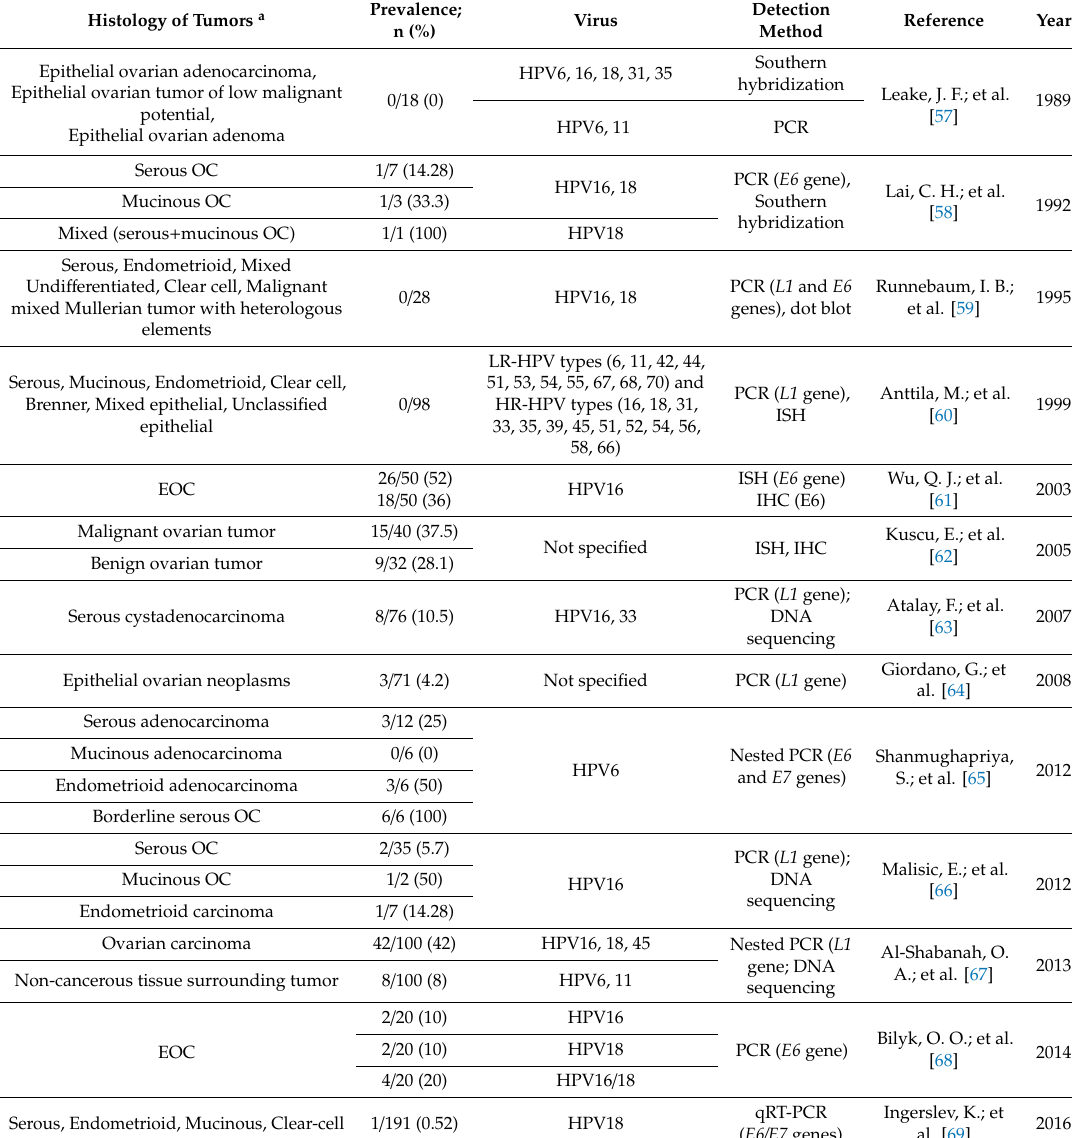
Table 1. Virus detection in ovarian